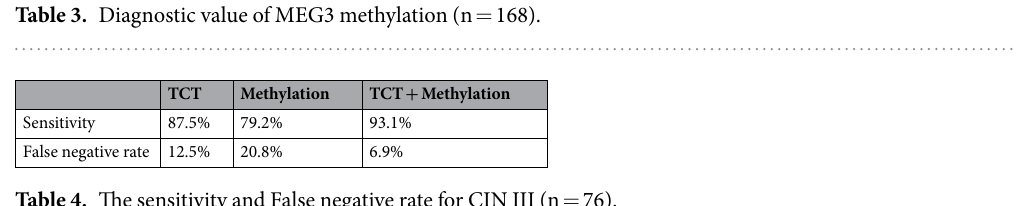
Table 4. The sensitivity and False negative rate for CIN III (n =